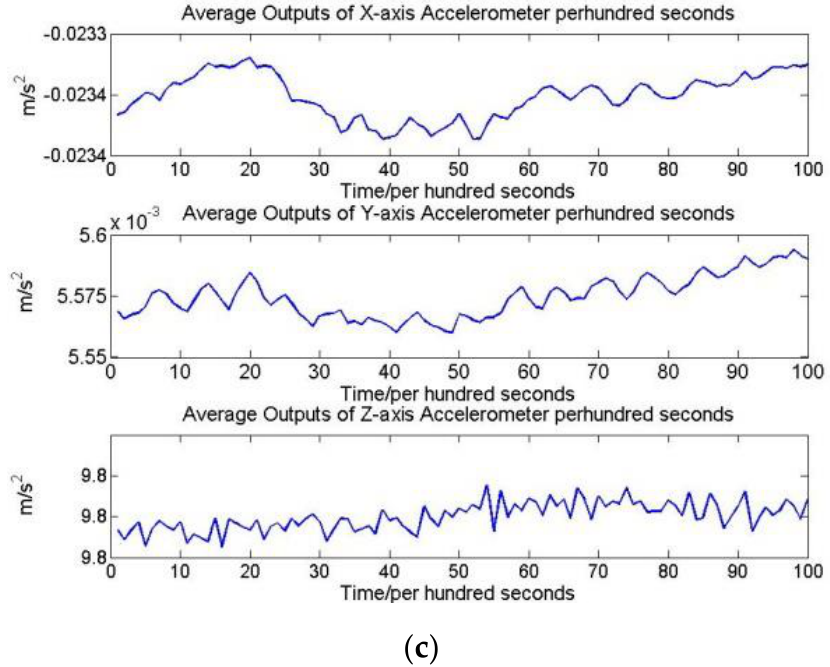
Figure 7. ( a ) Environment temperature variation, ( b ) accelerometers temperature variation and ( c ) the average outputs of accelerometers per hundred seconds.